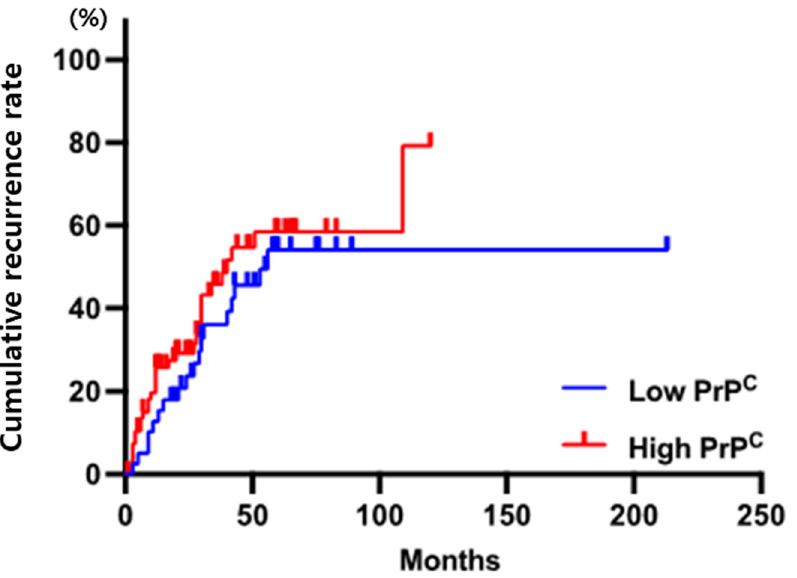
Figure 3. Kaplan–Meier curve to compare the cumulative survival rate according to four combina- tions between tumor size and PrP C expression. HCC patients with larger tumor and high PrP C ex- pression had poor cumulative survival ( p < 0.001).